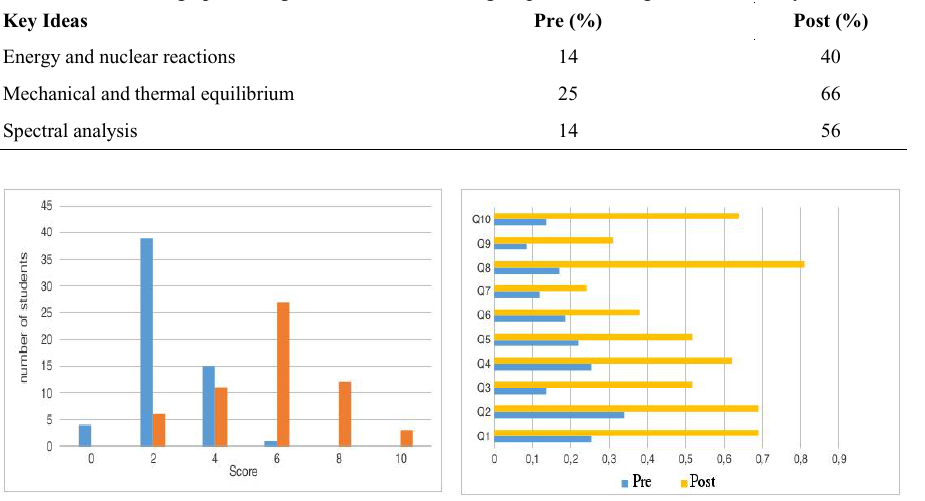
Table 3: Average percentages of correct answers grouped according to module’s key ideas.